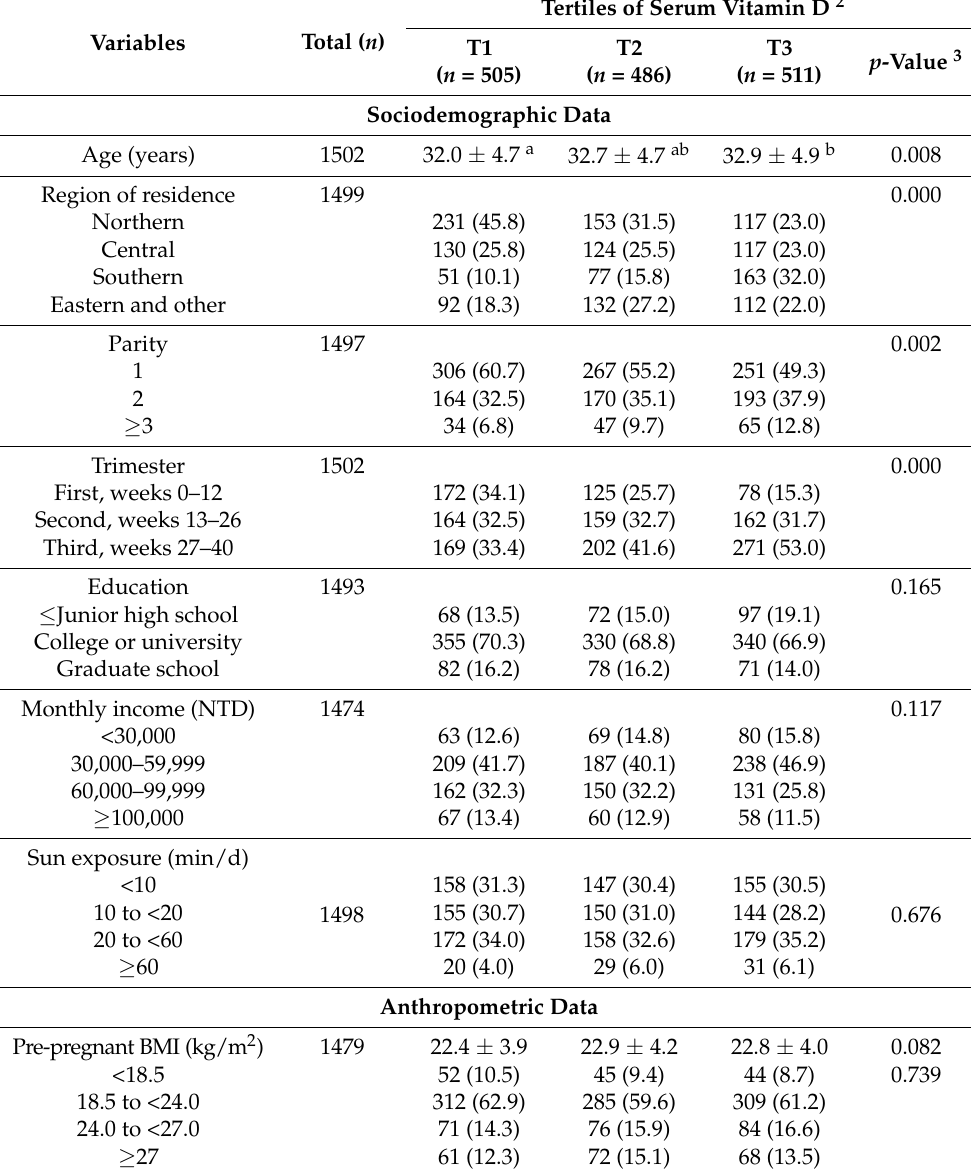
Table 1. Sociodemographic and anthropometric characteristics of the women across the tertiles of serum vitamin D ( n = 1502) 1